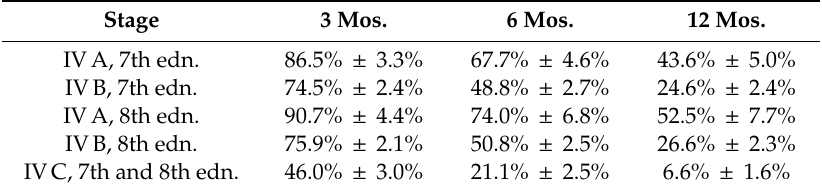
Table 4. The 3-, 6-, and 12-month OS rates of the ATC patients according to disease stage stratified by the 7th or 8th edition AJCC / UICC TNM classification.